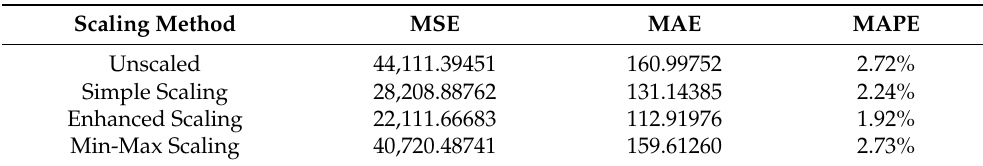
Figure 5. Graphic comparison of actual and predicted hourly load values for the year 2017. The values predicted through the min–max scaling method are added. Table 4. MSE, MAE and MAPE values for the hourly load forecast. Input data are subjected to a min–max scaling